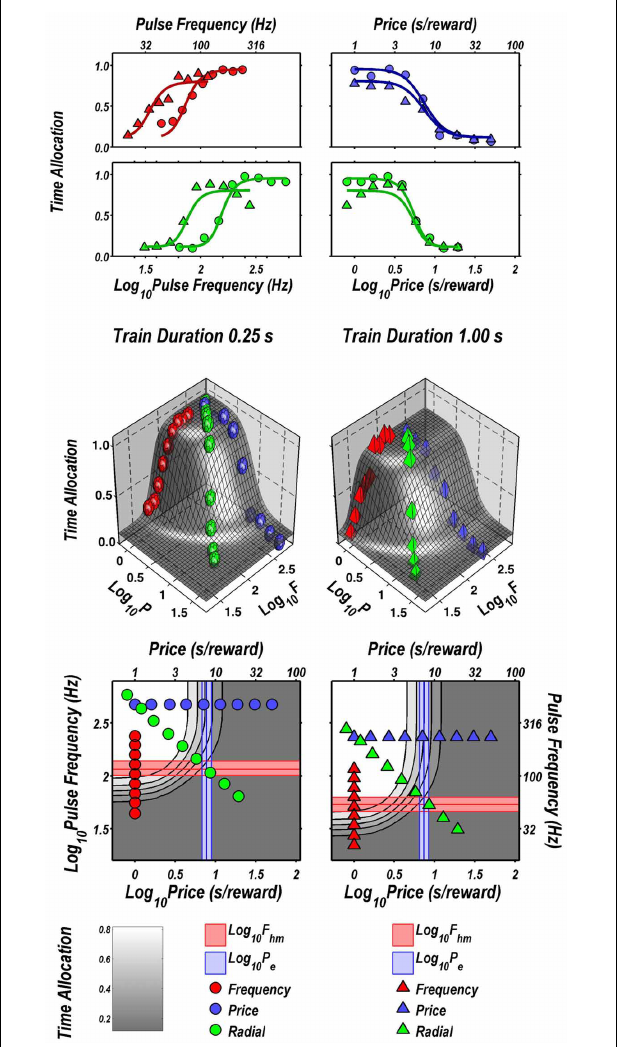
FIGURE 2 | Sample two- and three-dimensional representations of the data from Rat C26. The top four panels show the set of “pseudo-sweeps” (see section Behavioral Testing) comprising the reward mountain. Upper left : time allocated to reward pursuit as a function of pulse frequency (red circles: 0.25s duration; red triangles: 1.0s duration) with price held constant. Shortening the train duration shifts the curve toward higher pulse frequencies. Upper right : time allocated to reward pursuit as a function of price with pulse frequency held constant at a high value. This is one of the three cases in which changes in train duration did not alter the position of the mountain along the price axis (blue circles: 0.25s duration; blue triangles: 1.0s duration). Second row: time allocated to reward pursuit as a function of conjoint variation in both pulse frequency and price (green circles: 0.25s duration; green triangles: 1.0s duration). Time allocation along the radial pseudo-sweep is plotted against pulse frequency (left panel) and price (right panel). Third row : 3D surfaces showing how time allocation varies as a function of pulse frequency and price. Individual data means along the pulse-frequency (red), price (blue), and radial (green) sweeps are designated by polyhedrons (0.25s trains) or pyramids (1.0s trains). Bottom row: contour graphs corresponding to the surfaces in the row above. The vertical blue line represents the estimate of P e , and the surrounding band represents the corresponding 95% confidence interval. The horizontal red line represents the estimate of F hm , and the surrounding band represents the corresponding 95% confidence interval.